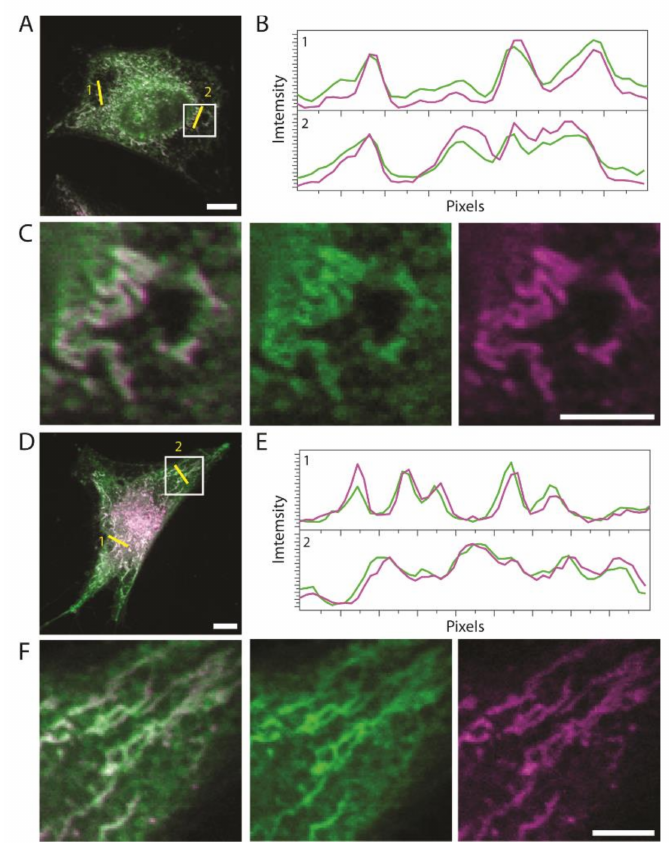
Figure 1. Dual-color confocal microscopy of 1 ( A – C ) and 2 ( D – F ) in formaldehyde-fixed HeLa cells. ( A , D ) Overlaid images of the dye (green) and MT (purple). Scale bars represent 10 µ m. ( B , E ) Intensity profile traces extracted from the yellow lines in A , D . ( C , F ) Magnified image of the area in the white square, showing the two color channels split. Scale bars represent 5 µ